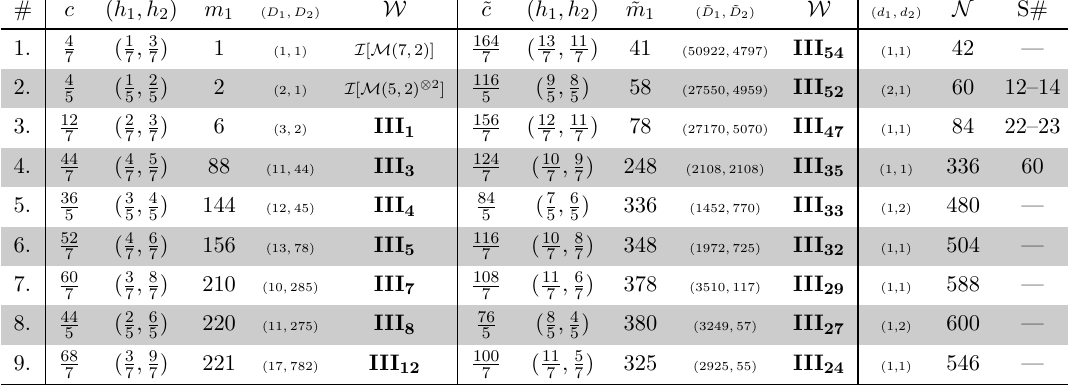
Table 9. IVOA-type pairings, c H = 24 with ( n 1 , n 2 ) = (2 , 2) . Wherever present, the entry in the last column identifies the meromorphic theory by its row number in the table of